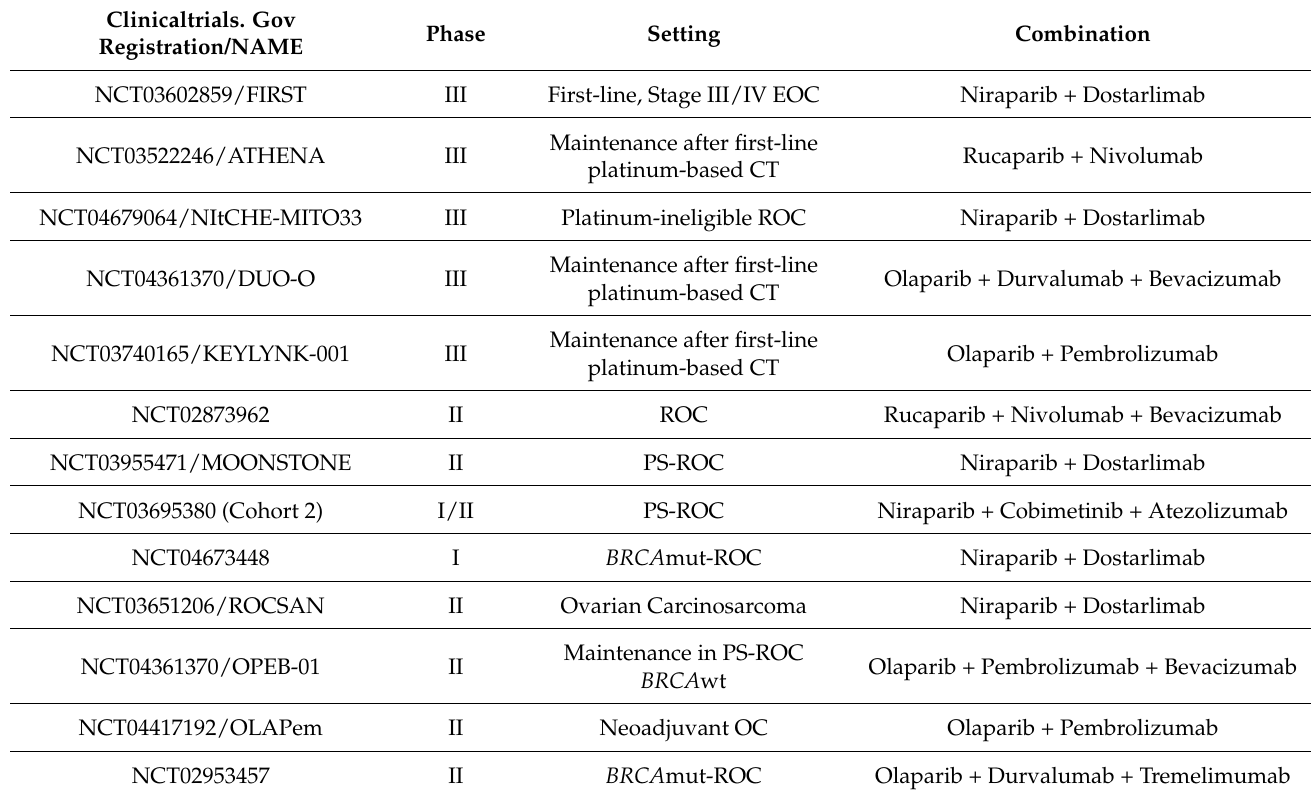
Table 2. Ongoing trials of PARPis and ICIs combination in